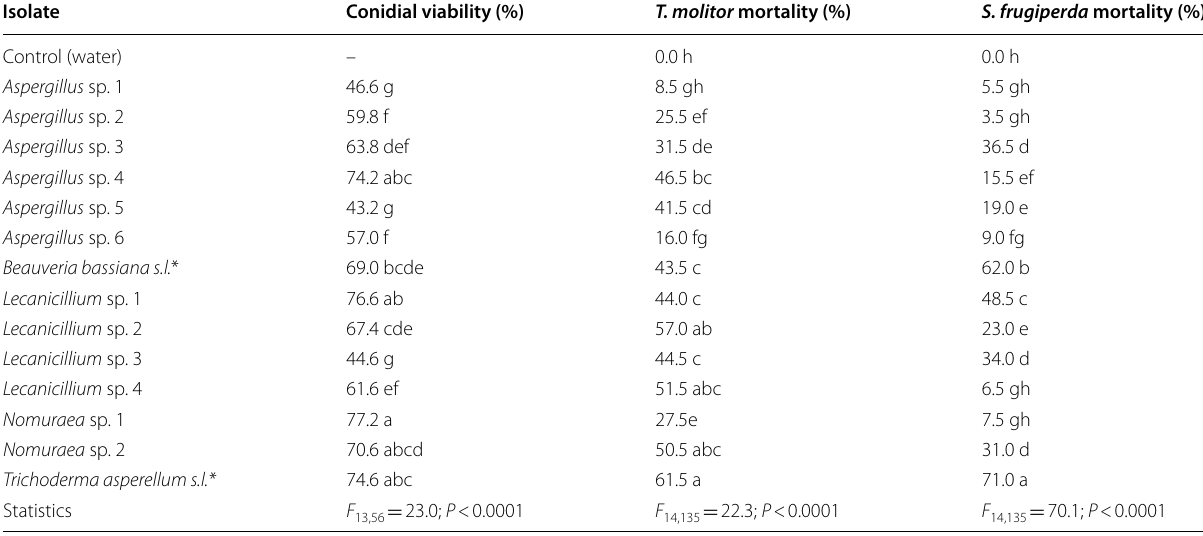
Means followed by the same letters within each column are not significantly different at P < 0.05 according to DMRT. Asterisk (*) indicates that the isolate was further identified based on its morphological characteristics and defined sensu lato (abbreviation “ s.l. ”)